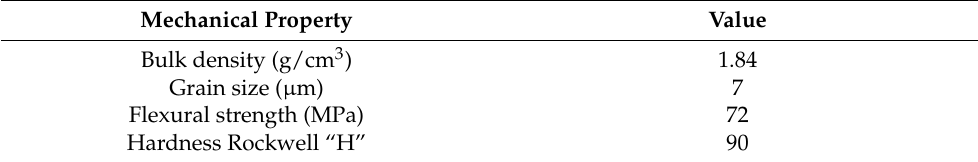
Table 1. Mechanical properties of G5 workpiece. (Refer to the datasheet of G5 provided by Mersen).